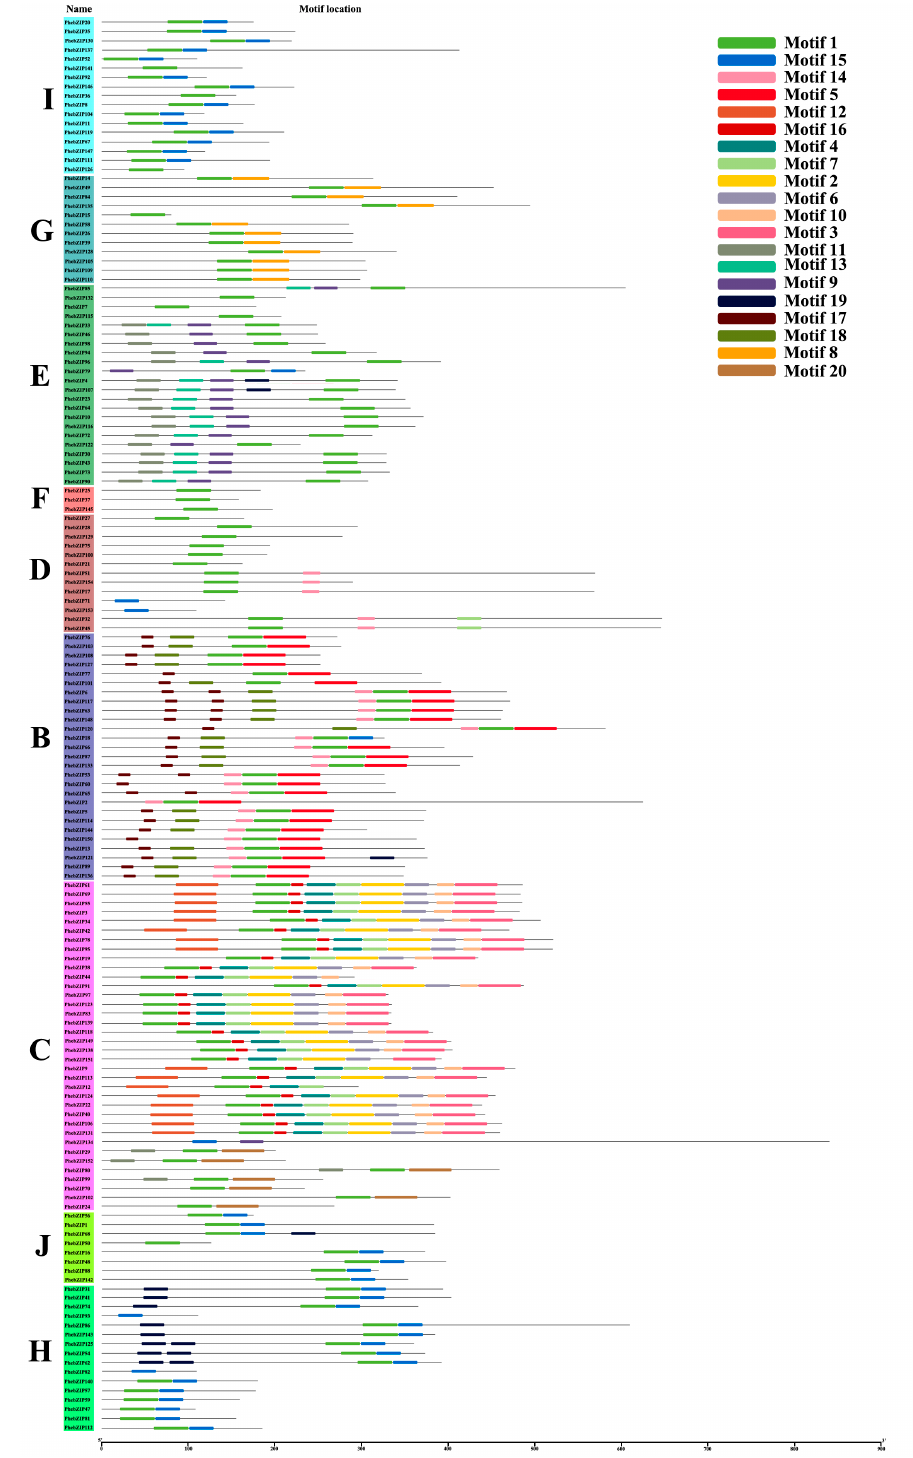
Figure 3. Schematic representation of 20 conserved motifs in PhebZIP proteins. Motifs of the PhebZIP proteins were identified using the MEME online tool. Each motif is indicated by different colored blocks, with respective numbers in the center of the motifs. The number in boxes (1–20) represents motif 1–motif 20. The position and length of each colored box represents the actual motif